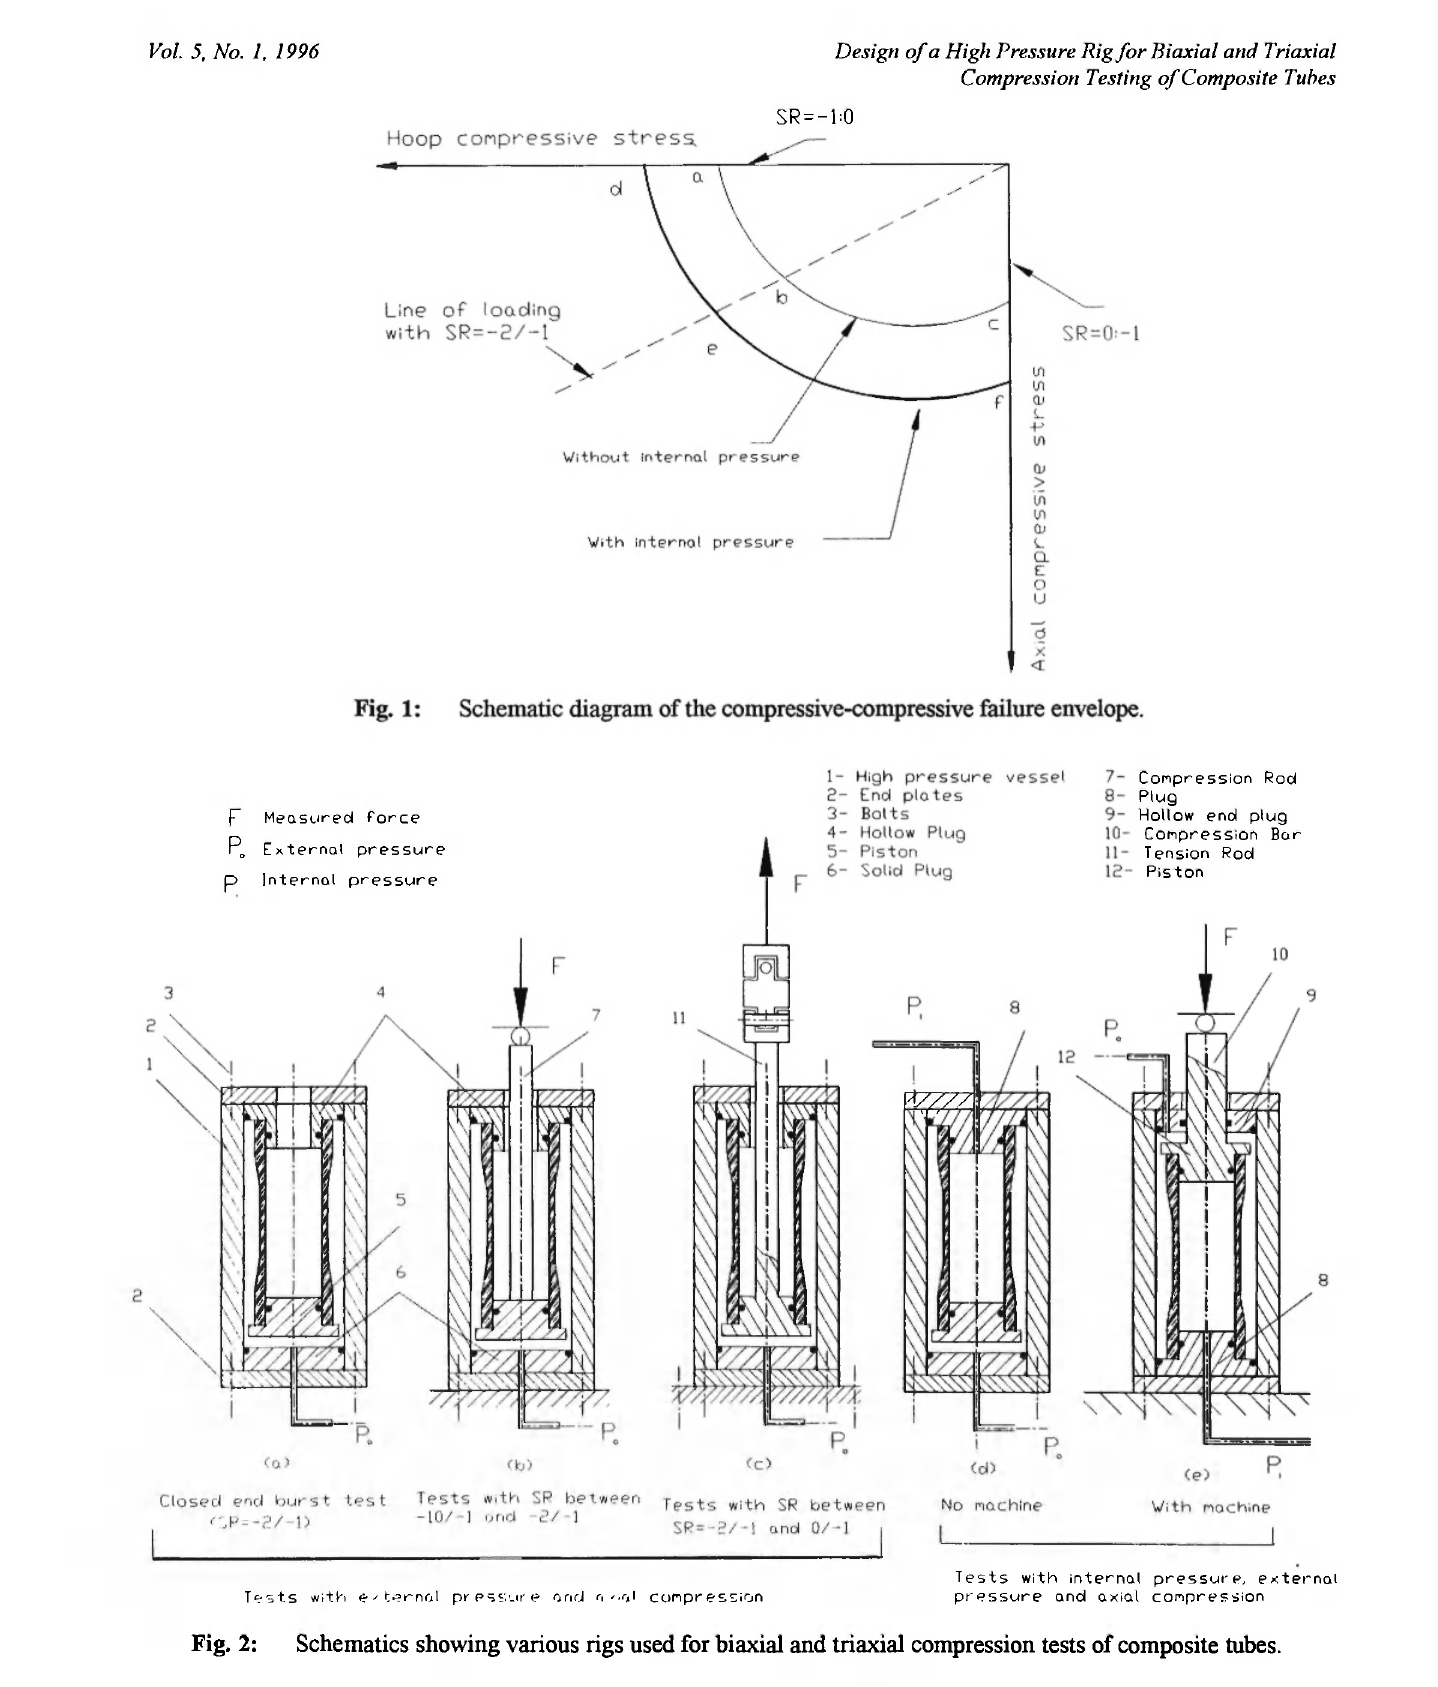
Fig. 2: Schematics showing various rigs used for biaxial and triaxial compression tests of composite